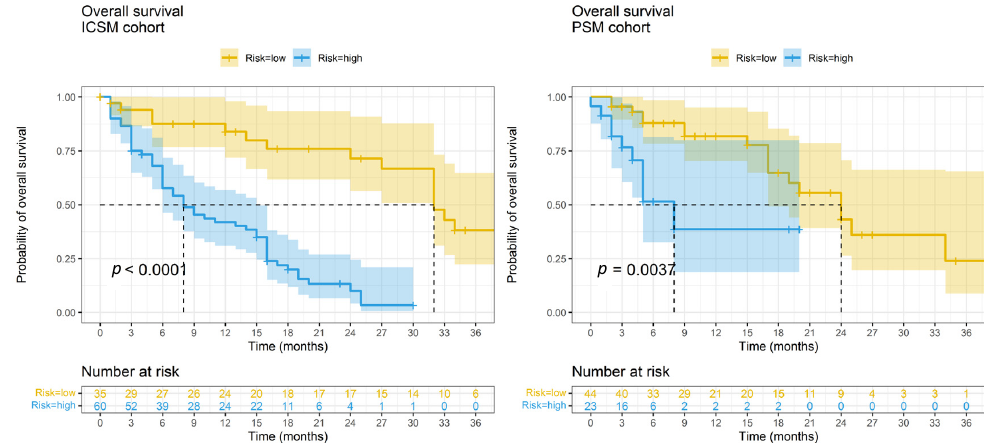
Figure 4. Kaplan–Meier curves of high and low risk of death patients based on OS nomograms predictions. Survival profiles of patients at high risk of death (characterized by total points from the OS nomogram ≥ 87) and low risk of progression (characterized by total points from the OS nomogram < 87) in the ICSM and OSM datasets, respectively. p = p -value from the log-rank test. Graphical representation was truncated at 36 months.